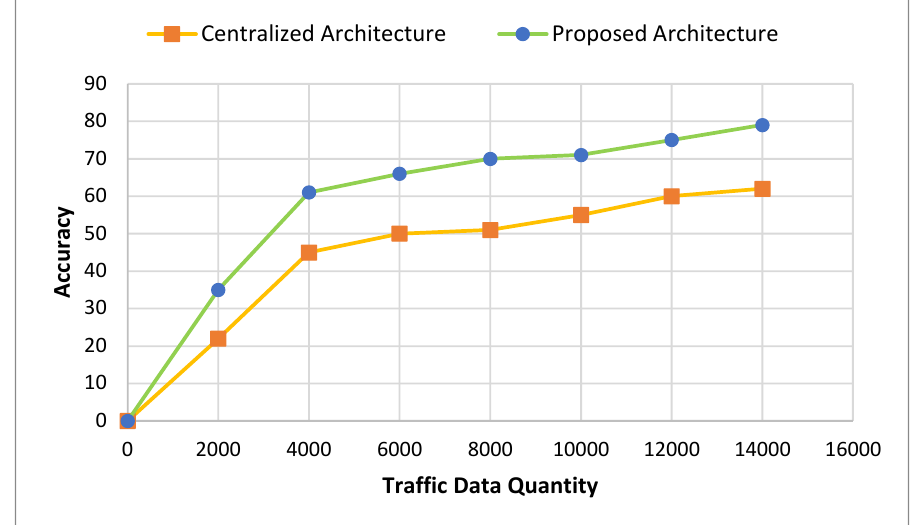
Figure 12. Accuracy measurement of security in data traffic quantity.